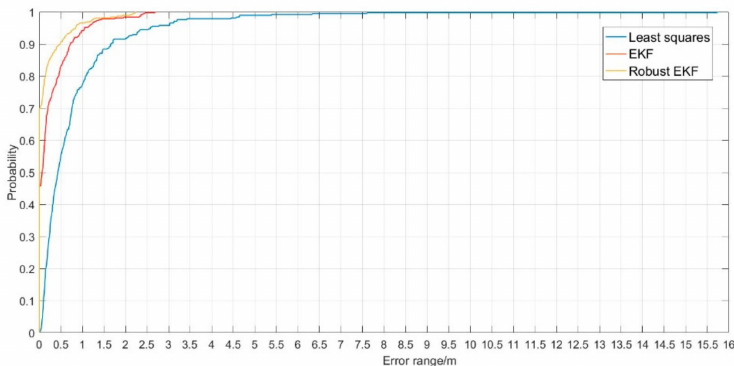
Figure 15. The cumulative distribution of plane error calculated based on three filtering